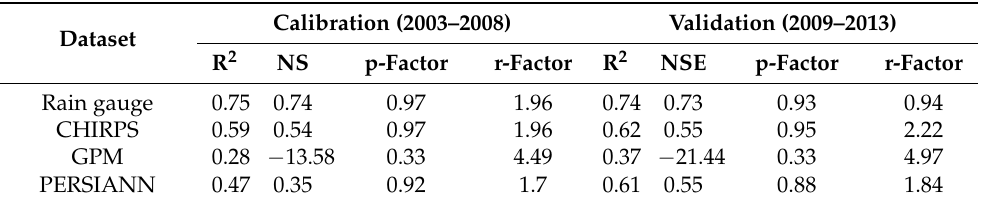
Table 8. Accuracy and uncertainty of SWAT daily models from four rainfall sources.